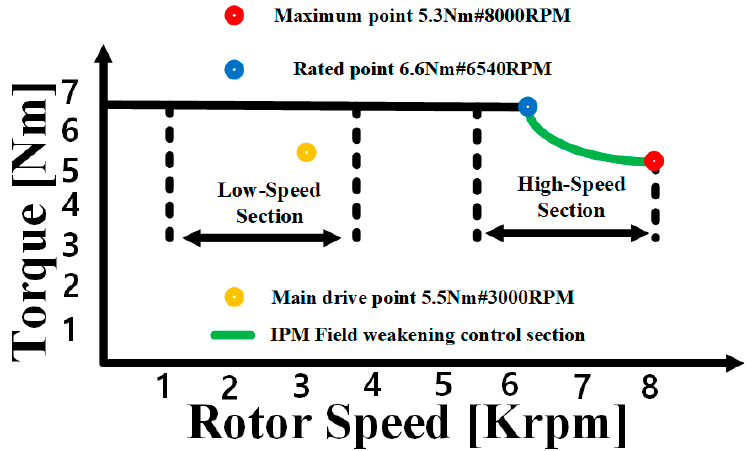
Figure 1. Required torque–speed curve of the motor for the compressor applications .